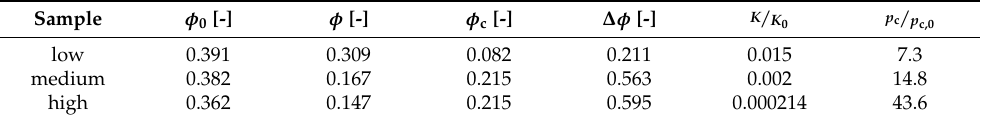
Table 4. Unmineralized ( φ 0 ) and mineralized porosities ( φ ), average CaCO porosity reduction ( ∆ φ ), the normalized permeabilities of the mineralized sample ( K / K 0 ), and the Leverett-scaling factor ( p c / p c,0 ) computed according to Equation (7) of the 3D experiments. Sample φ 0 [-] φ [-]